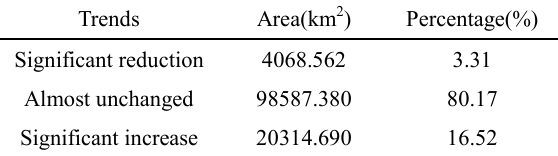
Table 1. Trend statistics of FVC in the source region of the Yellow River 3.3.2 Qualitative analysis of spatial change of vegetation coverage: According to the slope distribution map of FVC change in the source region of the Yellow River from 2000 to changes in the source region. The absolute value of the image represents the drastic degree of FVC change(Feng et al, 2014),